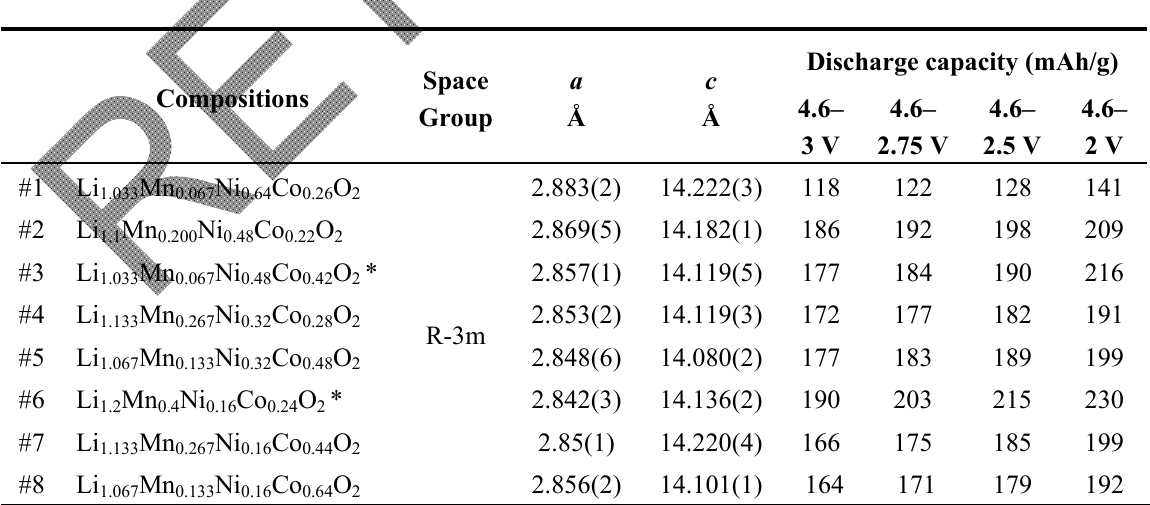
Table 1. Compositions, crystal structure, and electrochemical results of (1 – x –